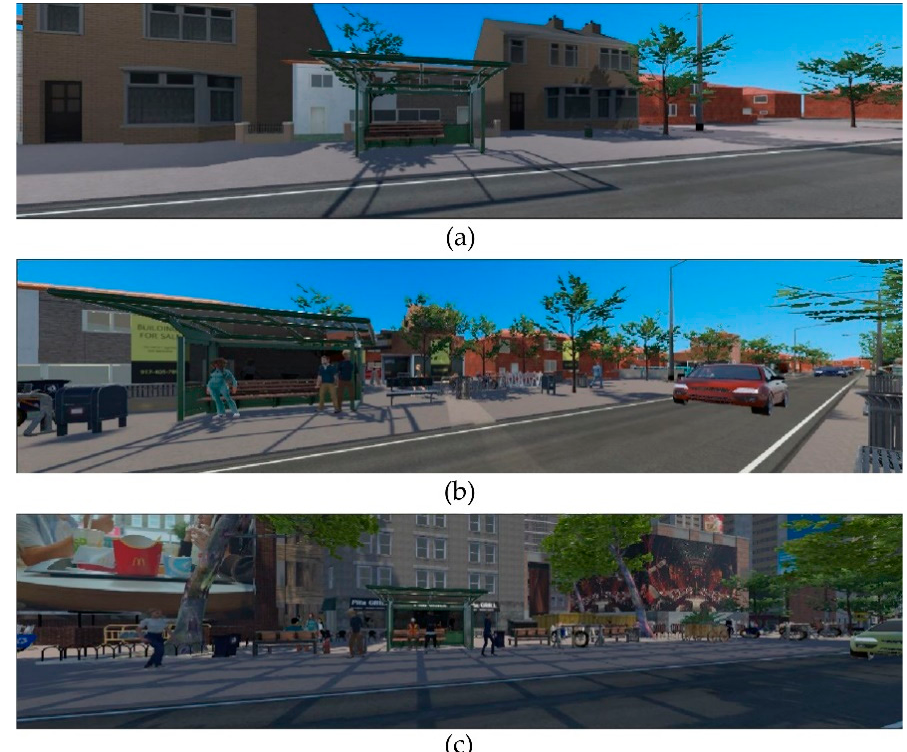
Figure 2. Example scenarios of increasing levels of visual load: ( a ) visual load < 100, ( b ) visual load = 100–199; ( c ) visual load = 200–300. Few road elements are present in the low visual load scenario, whereas the scene becomes more cluttered as the number of elements increases in the medium and high visual load scenarios. Table 1. Summary of study crossing